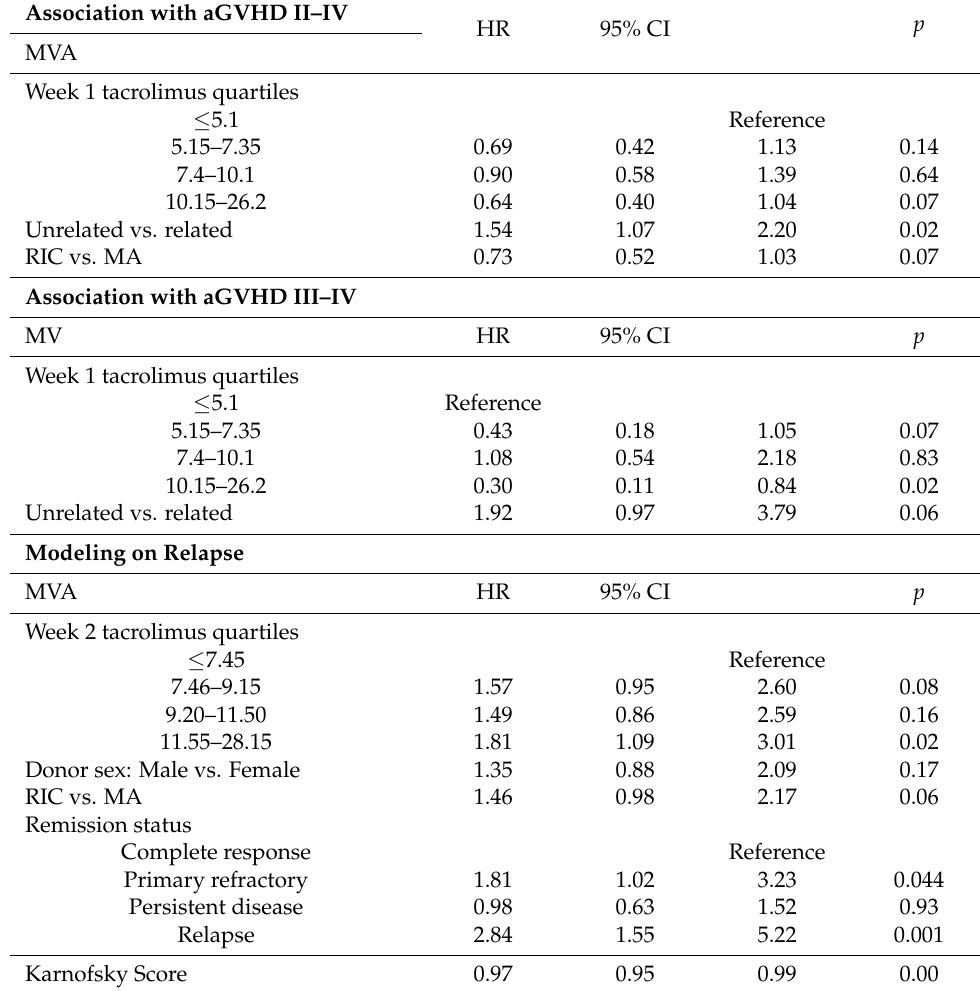
Table 4. Multivariable analysis for factors affecting the incidence of aGVHD and relapse in AML/MDS